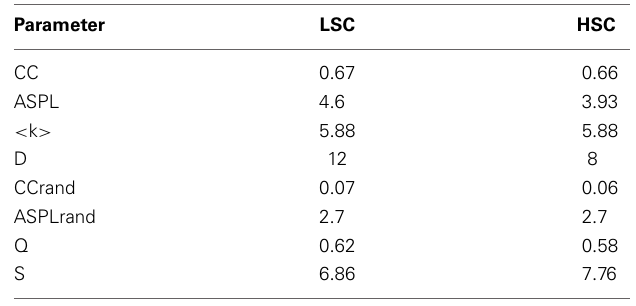
Table 3 | SWN measures calculated for the LSC semantic network and the HSC semantic